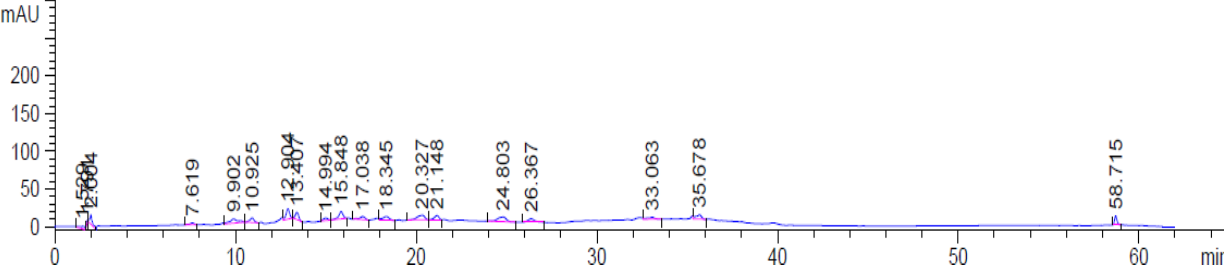
Figure 1. The HPLC chromatogram of the AvS ethanolic extract shows different peaks representing the phenolic compounds of the seeds. Table 2. Phenolic profile of avocado seeds as detected by HPLC.